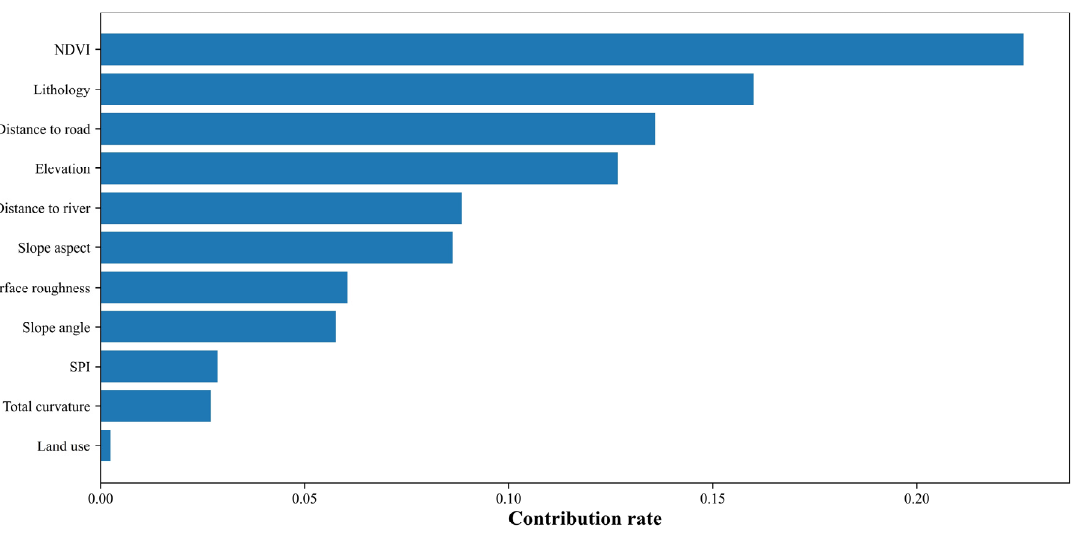
Figure 5. Contribution rate of the conditioning